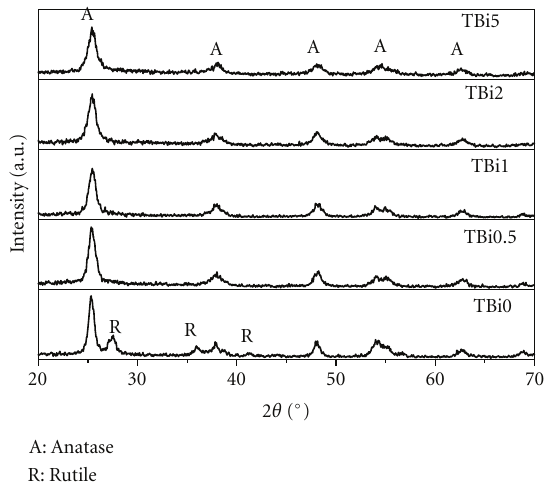
Figure 1: XRD patterns of Bi-doped TiO 2 spheres with 0, 0.5, 1, 2, and 5% of